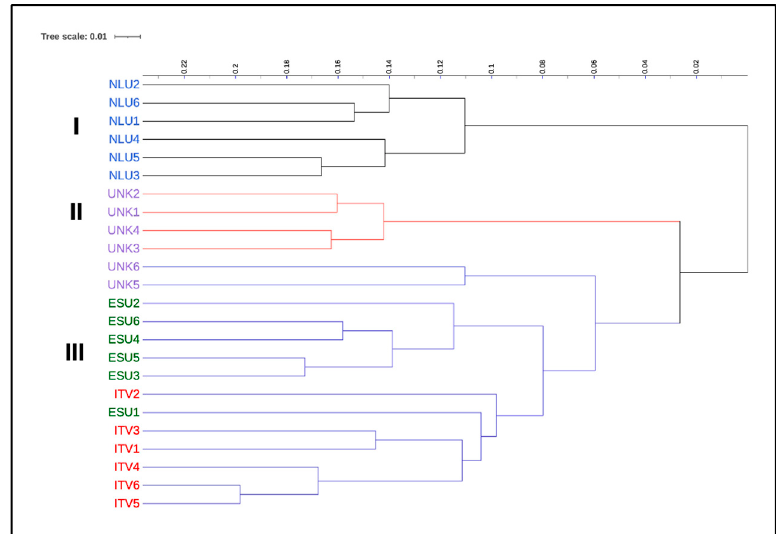
Figure 4. Dendrogram (UPGMA method) obtained from the Gower distance matrix calculated based on the morphological traits of the trunk, branches, and leaves of 24 A. araucana accessions individuated in the Pistoia nursery industry. Cophenetic correlation 0.80. Main clusters are indicated as I, II and III.